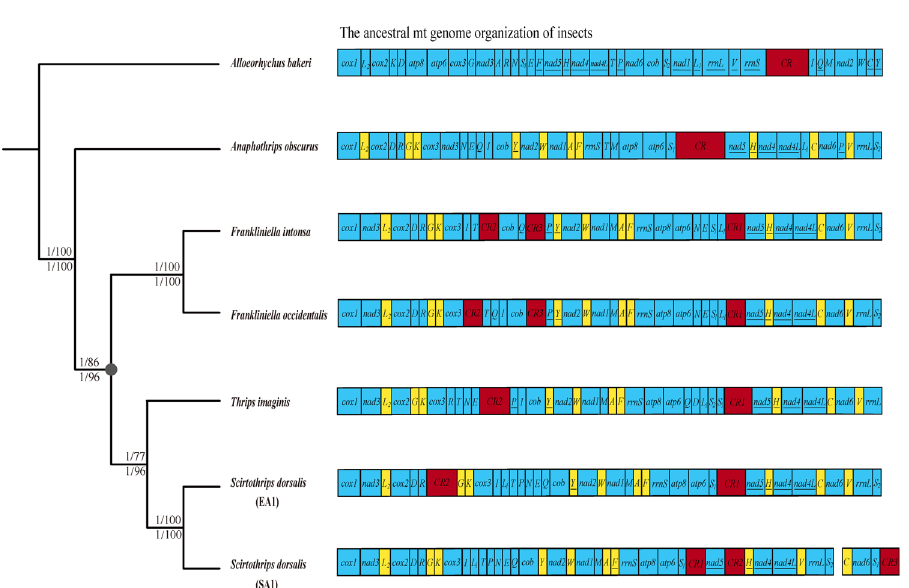
Figure 3. The phylogenetic tree inferred from the mitochondrial genome sequences of five species of thrips (left) and linearized mitochondrial genome organization of each thrips (right). Numbers at the nodes are ML bootstrap values and Bayesian posterior probabilities from the PCGR (upper) and PCG12R (lower) datasets. tRNA genes are abbreviated using their corresponding one-letter amino acid names. The CRs were marked as red boxes. The tRNA genes that are conserved among the five species of thrips in their location relative to their upstream and/or downstream genes were in yellow. Genes are transcribed from left to right except those underlined, which are transcribed from right to left. A grey dot at the node indicates the MRCA of the four thrips ( F. intonsa , F. ocidentalis , A. obscurus and S. dorsalis ) and the origin of the translocated nad3